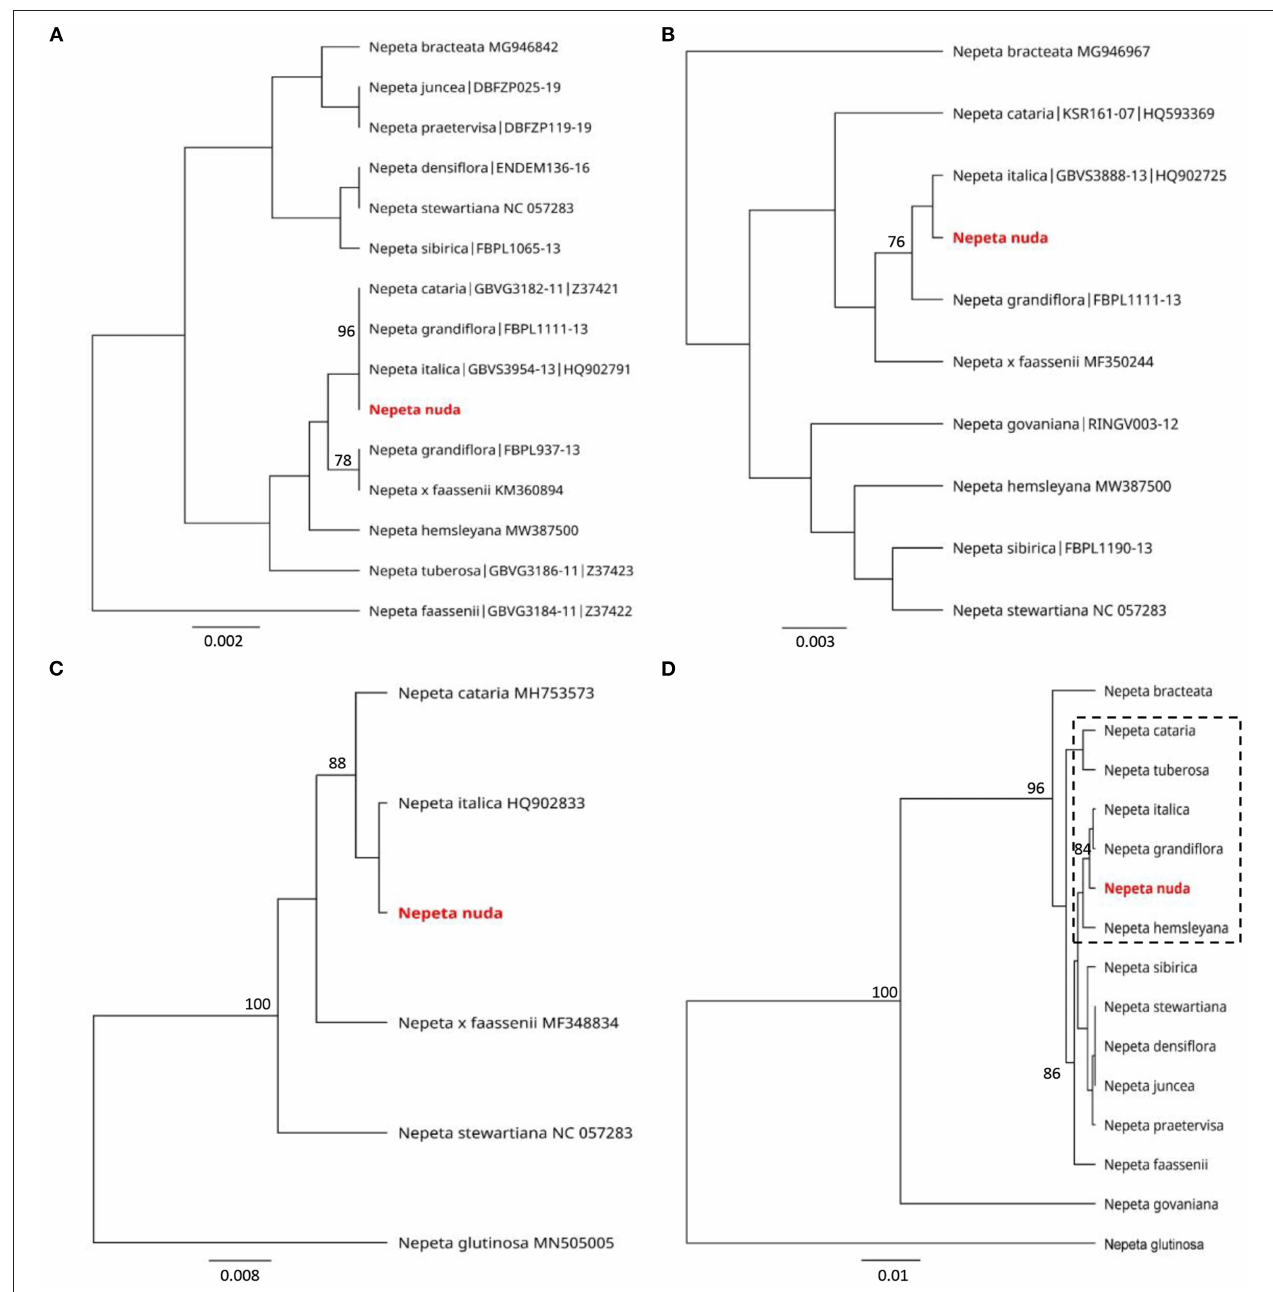
FIGURE 2 | Phylogenetic position of N. nuda against accessions from BOLD and NCBI GenBank based on chloroplast DNA barcoding markers rbcL (A) , matK (B) and trnH-psbA (C) and a consensus tree of all three markers (D) . The trees were constructed using the UPGMA method and Tamura–Nei model. The percentage of replicate trees in which the associated taxa clustered together in the bootstrap test (500 replicates) are shown next to the branches. Bootstrap values below 75% are not shown. The analyzed N. nuda sequence is depicted in red bold. Accessions from databases are shown with their respective numbers in (A–C) . In (D) , punctuated rectangle points to species in closest proximity to N. nuda